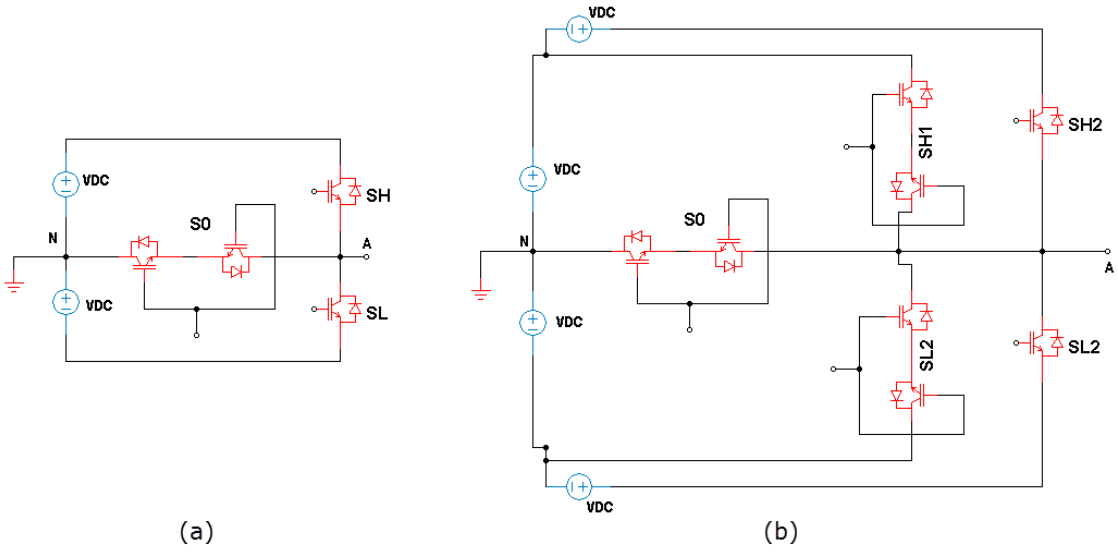
Figure 9. Modified T-MLI , ( a ) the proposed module, and ( b ) a five-level